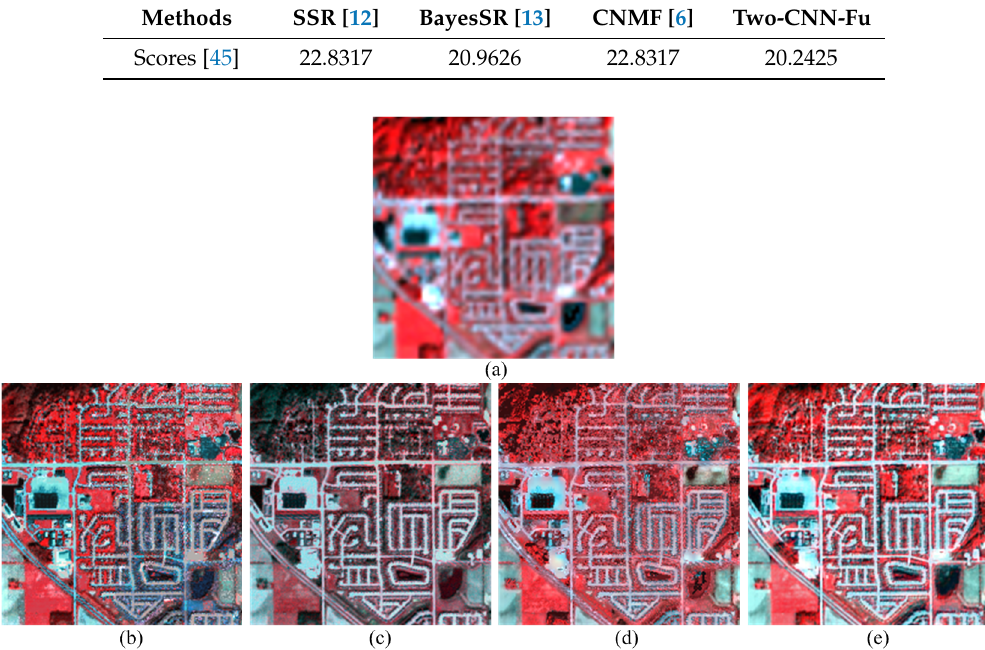
Table 5. The no-reference quality assessment scores of different results on Hyperion-Sentinel fusion.